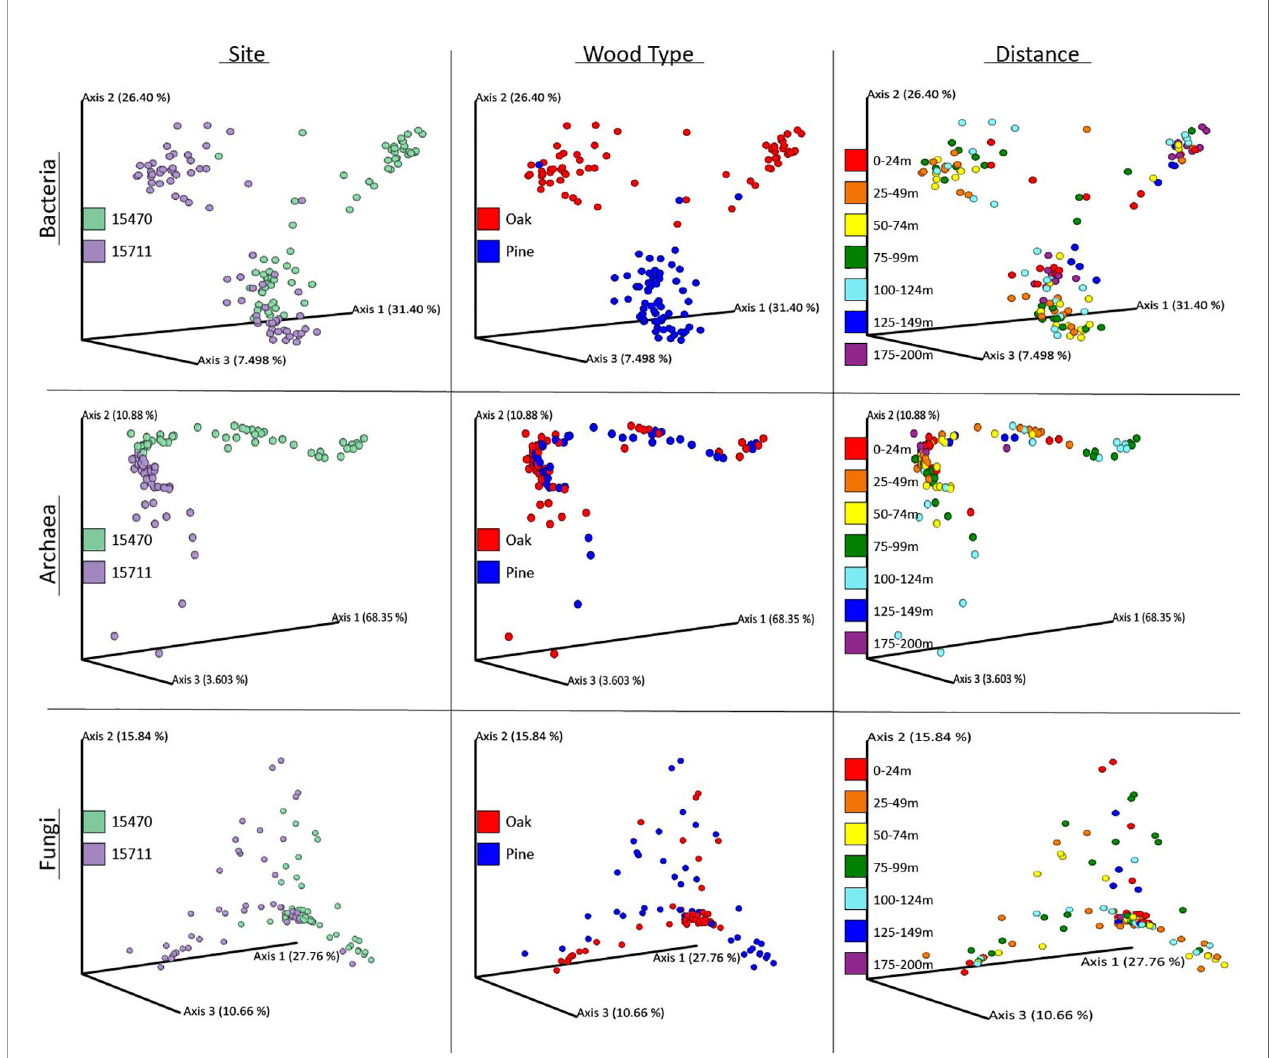
FIGURE 3 | Weighted UniFrac results displayed as PCoA for Site, Wood Type, and Distance for all three domains. Samples were grouped in distance categories spanning 25 m for visualization.